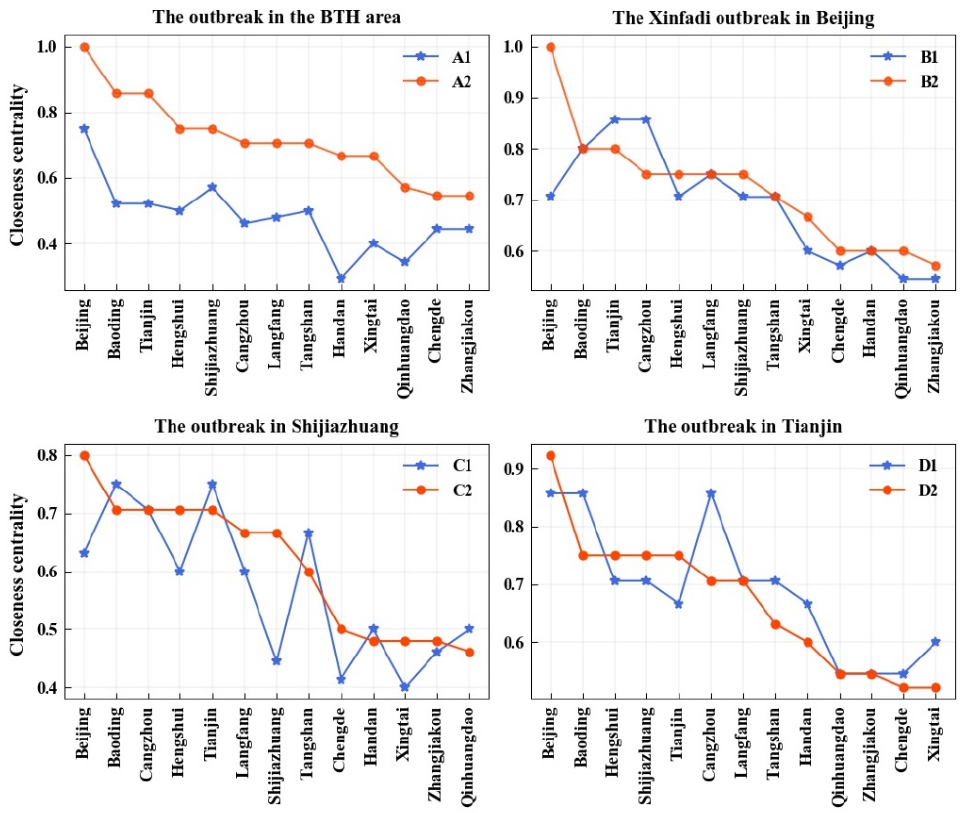
Figure 7. Changes in urban closeness centrality in the different